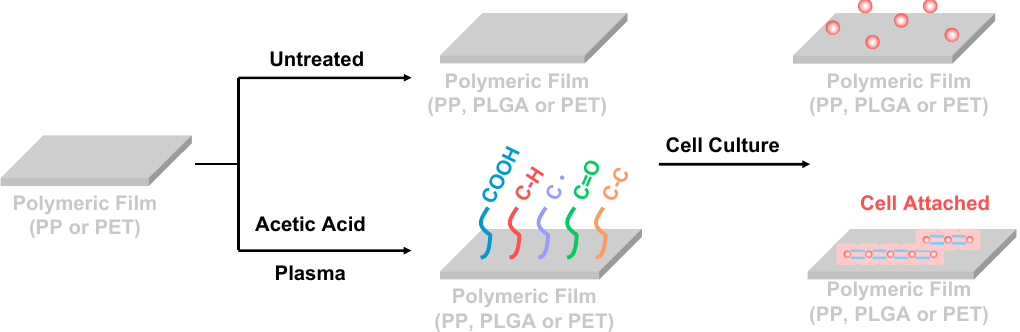
Figure 1. The schematic illustration of the preparation of polymeric film surface modification with acetic acid plasma and then cell culture.